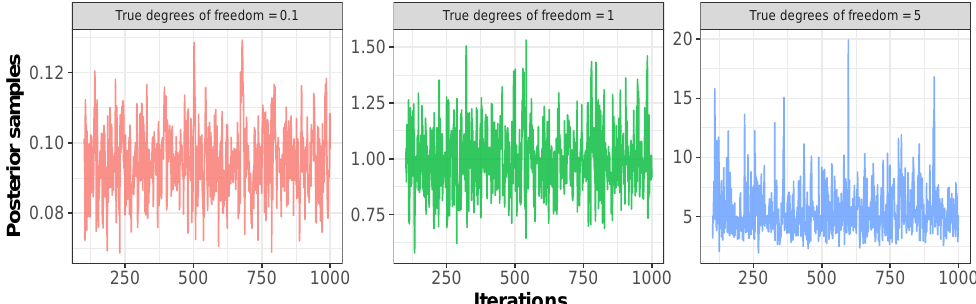
Figure 2. Trace plots for the three simulation experiments. Training data generated from Student ( x ) with ν = 0.1 ( left ), ν = 1 ( middle ), and ν t-distribution t ν 0 0 0